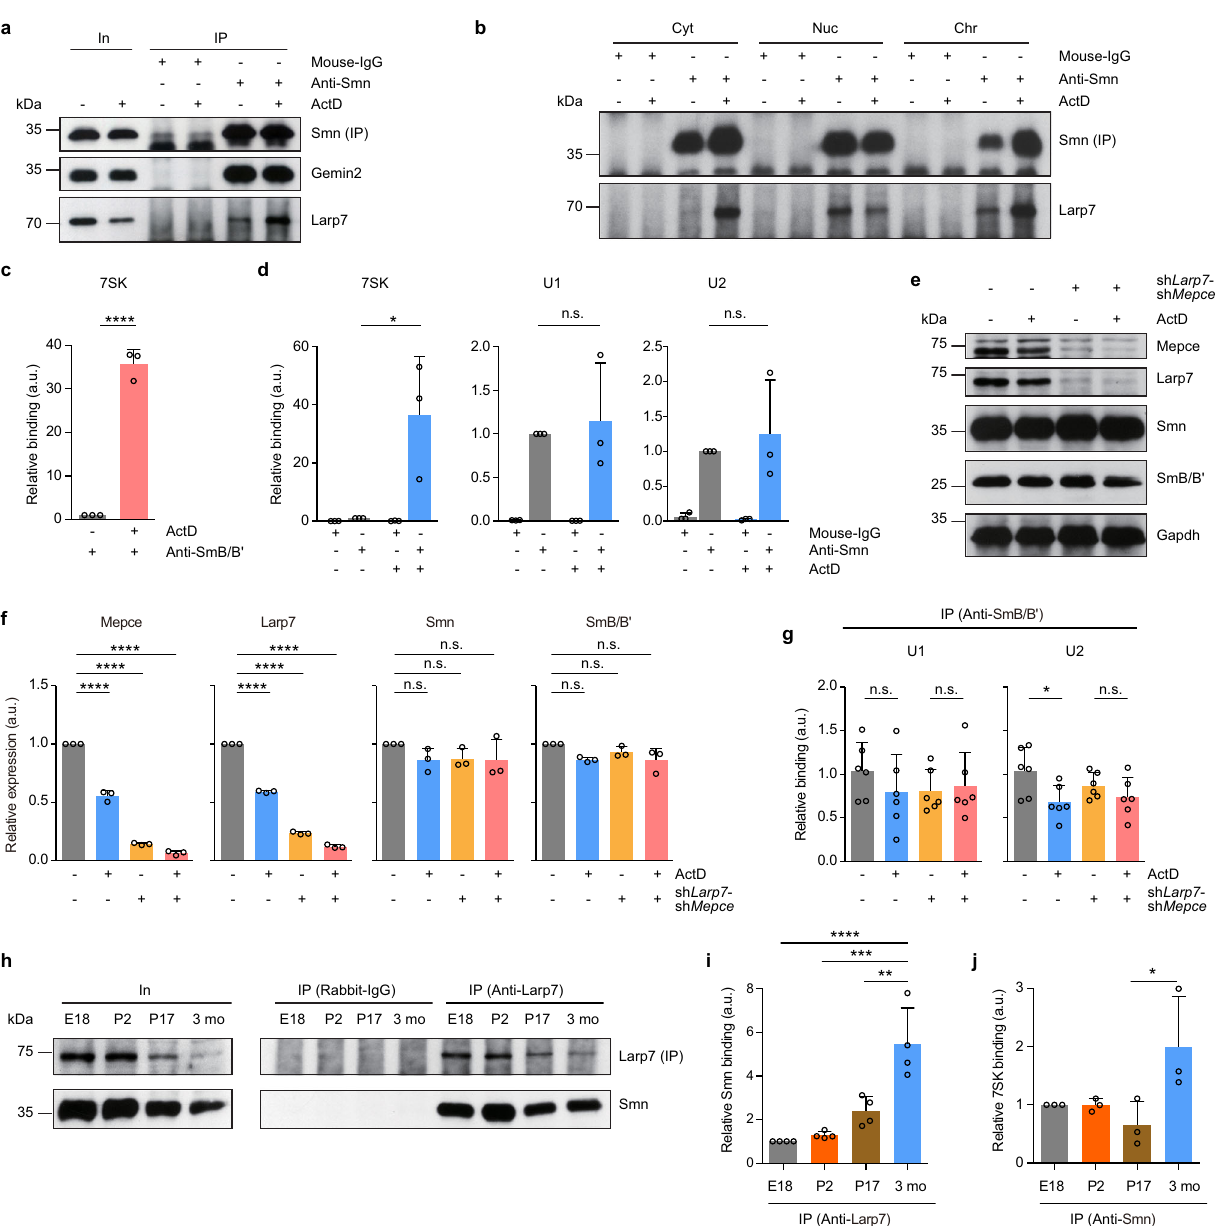
Fig. 6 The 7SK complex regulates Smn complex activity. a Western blot analysis of proteins co-immunoprecipitated by anti-Smn from NSC-34 cells treated with DMSO or ActD for 6 h. b Co-immunoprecipitation of Larp7 by anti-Smn from subcellular fractions of NSC-34 cells treated with DMSO or ActD for 1 h. Cyt, cytosol; Nuc, nuclear soluble proteins and organelles; Chr, chromatin-associated proteins. c qPCR analysis of 7SK co-precipitated by anti-SmB/ B ’ from NSC-34 cells treated with DMSO or ActD for 6 h. Data are mean ± s.d.; **** P ≤ 0.0001; unpaired two-tailed t -test ( n = 3). d qPCR analysis of 7SK and snRNAs co-precipitated by anti-Smn from NSC-34 cells treated with DMSO or ActD for 6 h. Data are mean ± s.d.; * P ≤ 0.05; n.s., not signi fi cant; two- way ANOVA with Tukey ’ s multiple-comparisons test ( n = 3). e Western blot analysis of Larp7/Mepce double-knockdown (sh Larp7 -sh Mepce ) or control NSC-34 cells treated with DMSO or ActD for 6 h. f Quanti fi cation of Western blot signals in e . Data are mean ± s.d.; **** P ≤ 0.0001; n.s., not signi fi cant; two-way ANOVA with Tukey ’ s multiple-comparisons test ( n = 3). g qPCR analysis of U1 and U2 snRNA co-precipitated by anti-SmB/B ’ from Larp7/Mepce double-knockdown or control NSC-34 cells treated with DMSO or ActD for 6 h. Data are mean ± s.d.; * P ≤ 0.05; n.s., not signi fi cant; two-way ANOVA